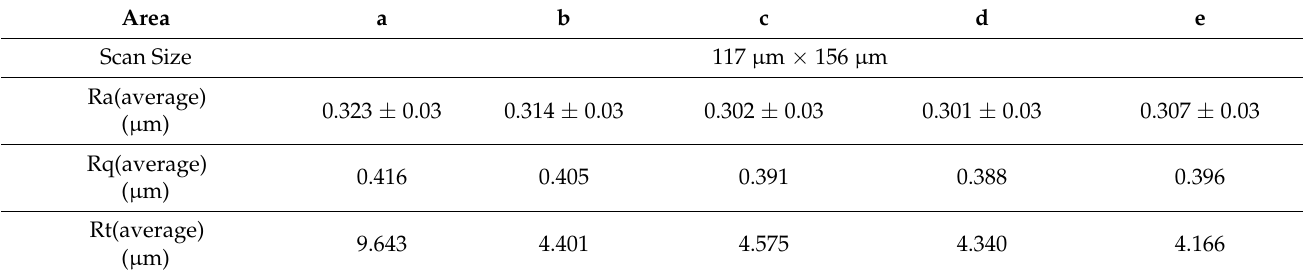
Table 3. The roughness parameters of dental implants for a scan size of 117 µ m × 156 µ m.